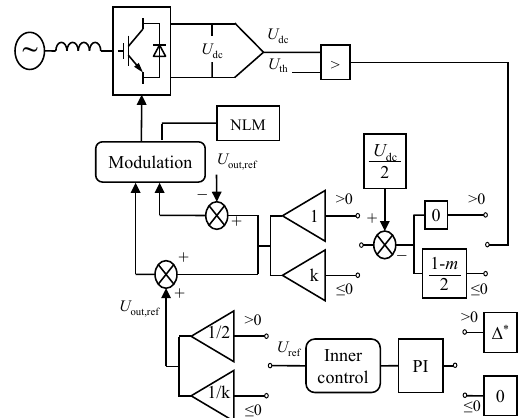
Figure 18. Block diagram of MMC based on partial bypass of SMs.